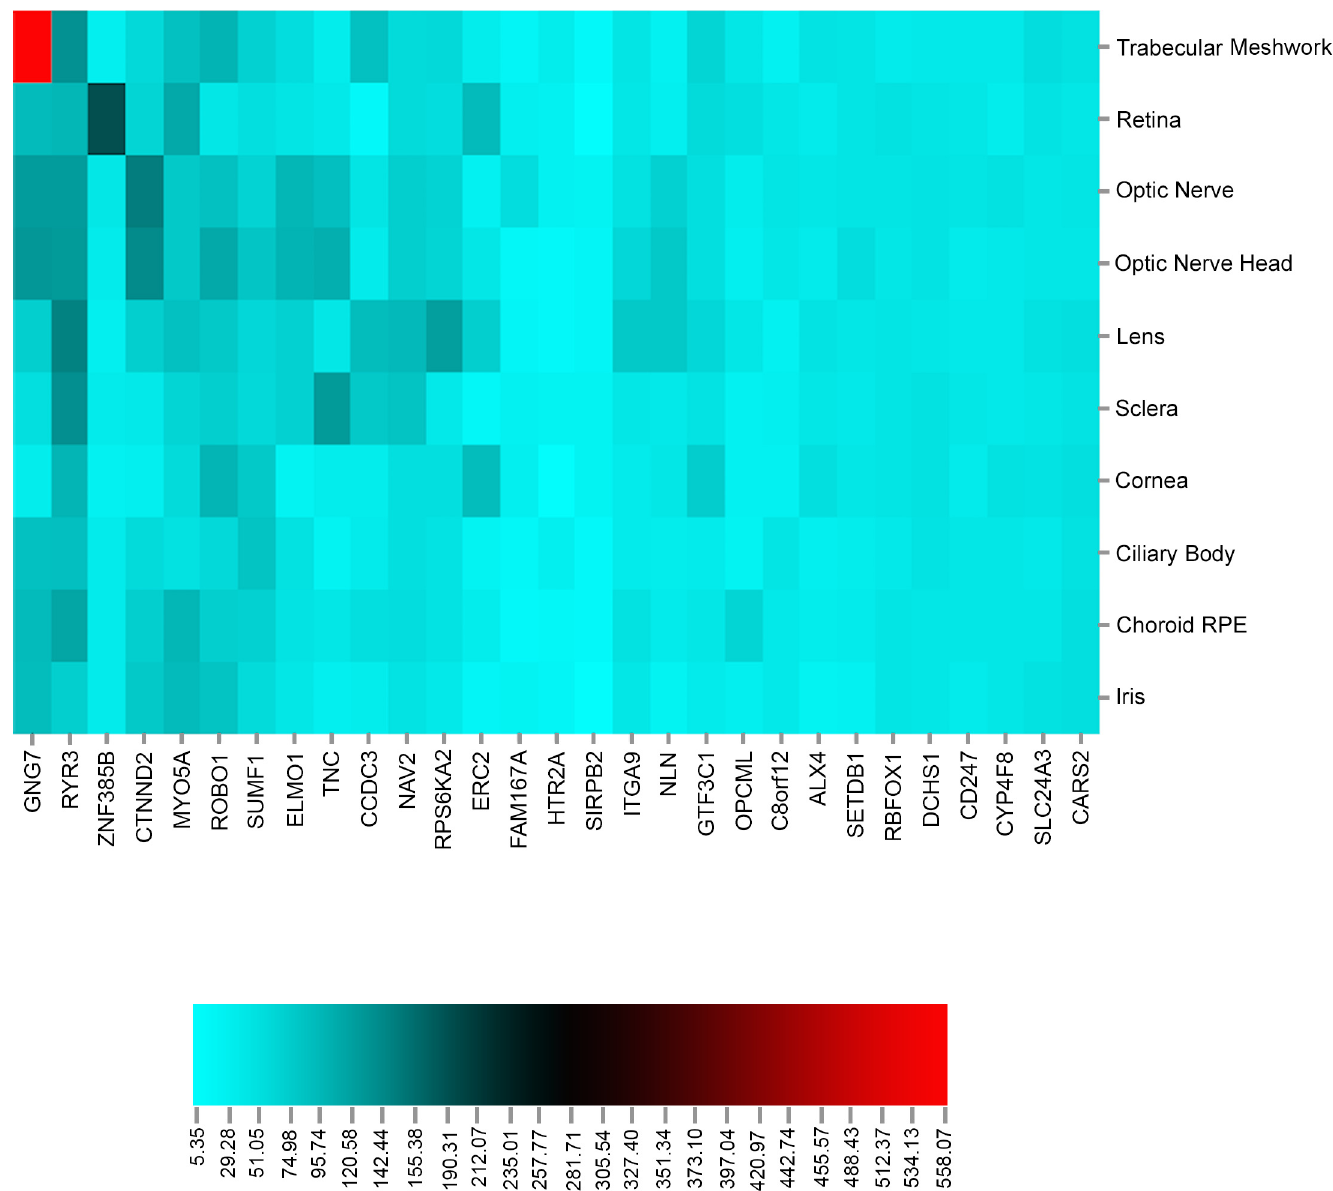
Fig 5. Heat map representing expression of the unique genes found in the ocular tissue database from GXG interaction results. Here, the x-axis lists all genes and y-axis lists the names of 10 tissues from the eye. Scale and color intensity represent PLIER values as reported in the ocular tissue